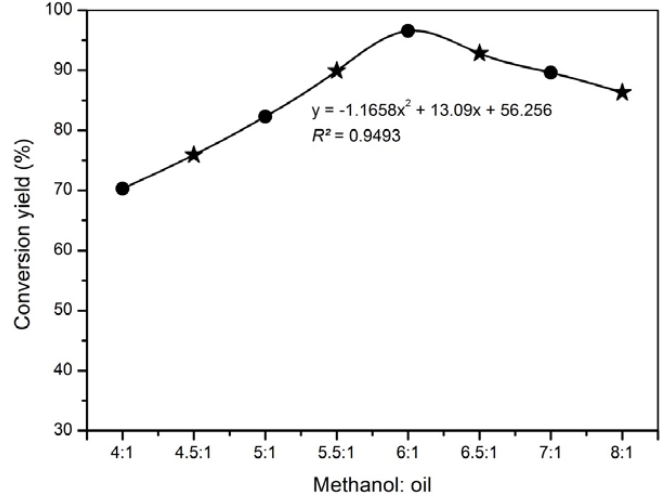
Figure 6. Effect of methanol–oil ratio on conversion yield for 1% KOH catalyst at 60 °C reaction temperature for 60 min reaction time.